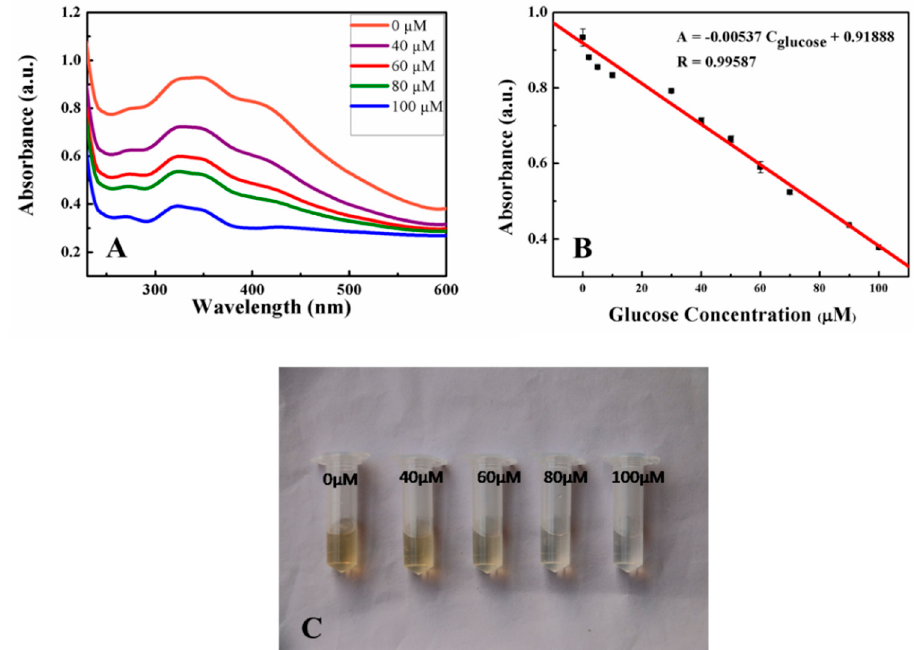
Figure 4. UV-vis spectra of the detection of different concentrations (0, 5, 50, and 100 μ M) of glucose ( A ), the linear relationship between the absorbance at 346 nm and glucose concentrations ( B ), and the visual detection of variable glucose ( C ). Error bars in ( B ) represented the SDs from three independent detections.